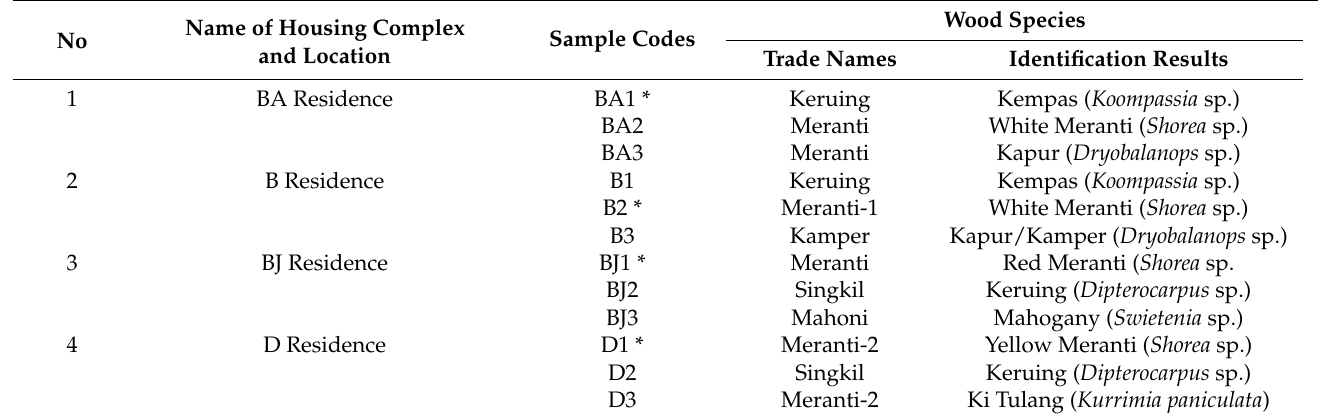
Table 3. The trade names and definitive wood species used in the housing